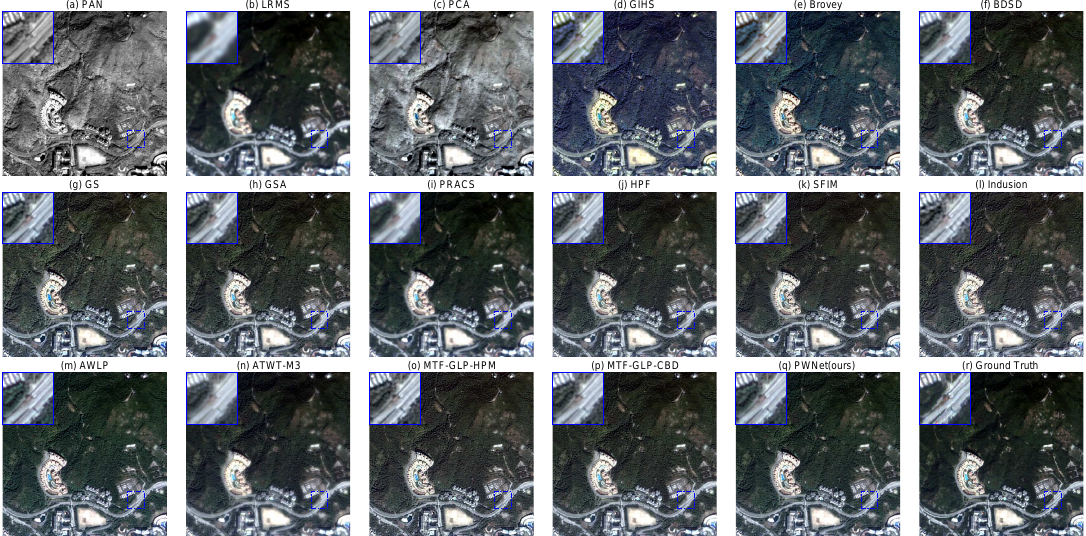
Figure 7. Visual comparison of the CS-based and MRA-based methods and the proposed PWNet method on the QuickBird images, ( a ) PAN; ( b ) LRMS; ( c ) PCA; ( d ) GIHS; ( e ) Brovey; ( f ) BDSD; ( g ) GS; ( h ) GSA; ( i ) PRACS; ( j ) HPF; ( k ) SFIM; ( l ) Indusion; ( m ) AWLP; ( n ) ATWT-M3; ( o ) MTF-GLP-HPM; ( p ) MTF-GLP-CBD; ( q ) PWNet (ours); ( r ) Ground